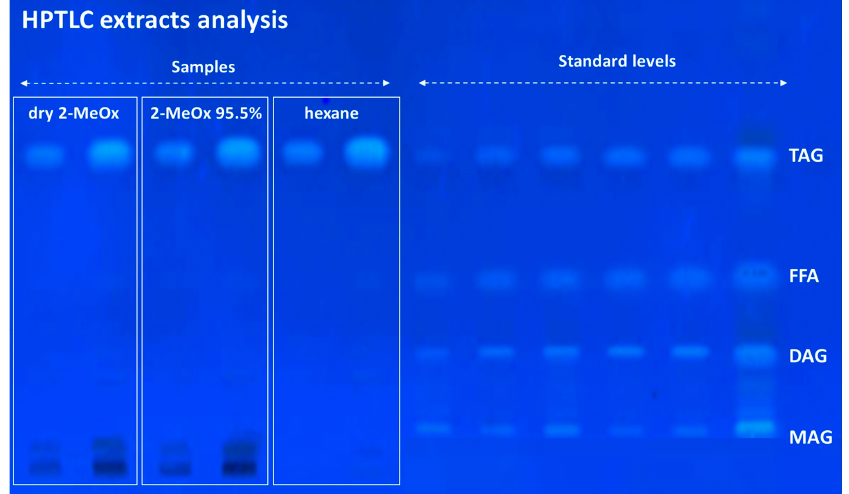
Figure 6. Neutral lipid analysis by HPTLC of OP extracts obtained with hexane, dry 2-MeOx and 2-MeOx 95.5%.